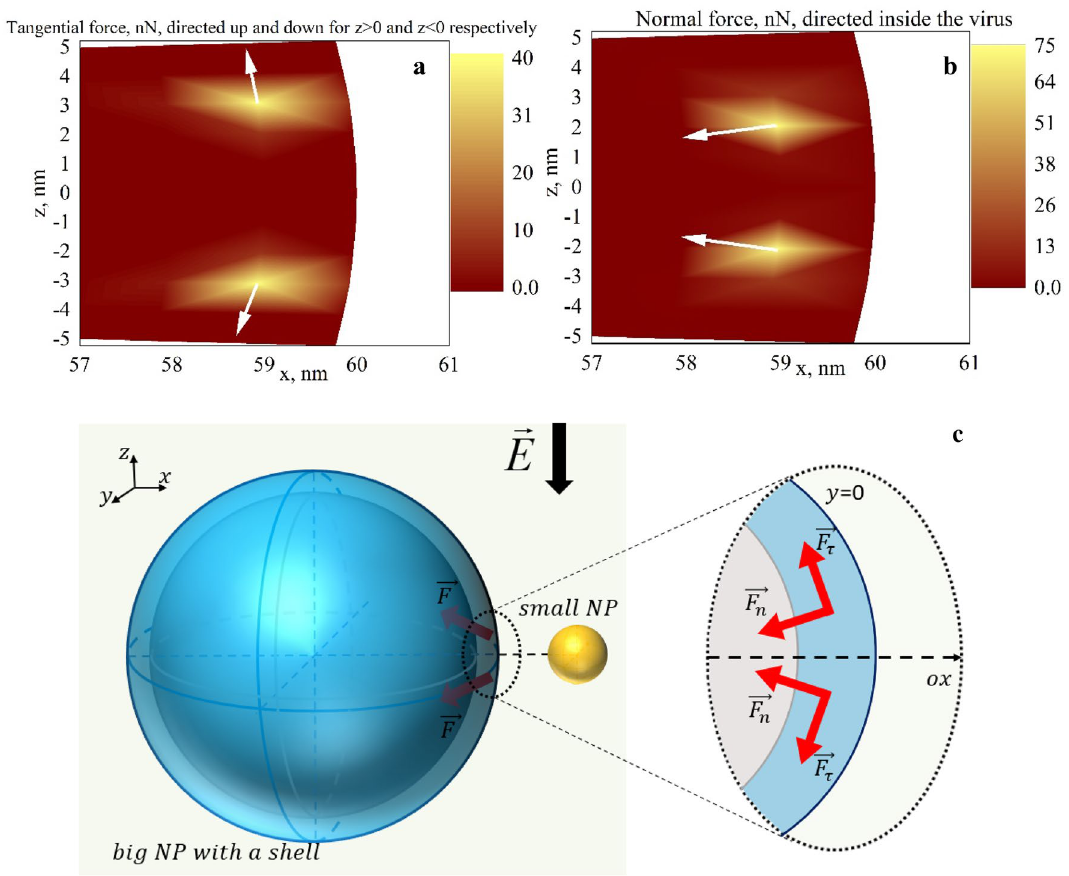
Figure 3. Distribution of tangential ( a ) and normal force ( b ) density on the surface of the nanoparticle of 60 nm radius with 10 nm shell ( ε core = 2 , ε shell = 4 ) located close to the nanoparticle of 2.5 nm radius with ε np = − 10.5 + 1.3 i in the medium with ε m = 1 , (cid:31) = 615nm , E = 1 V / m (The section at the y = 0 ). ( c )— Sketch of the forces acted on the bigger nanoparticle in the system of two different-sized nanoparticles.